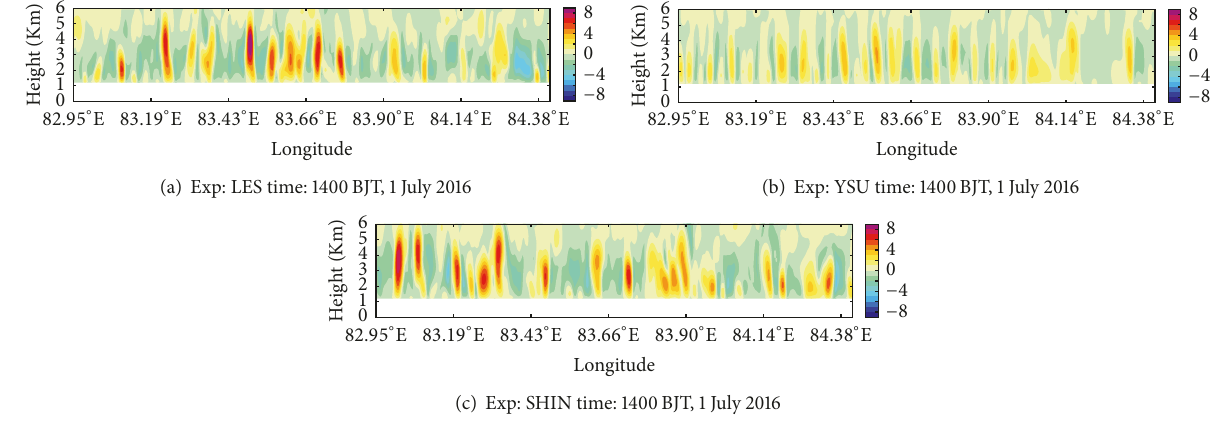
Figure 9: Vertical cross-section of instantaneous vertical velocity fields (shading: m/s) along A 1 -A 2 in for (a) WRF-LES, (b) YSU, and (c) Shin-Hong at 1400 BJT, 1 July 2016.